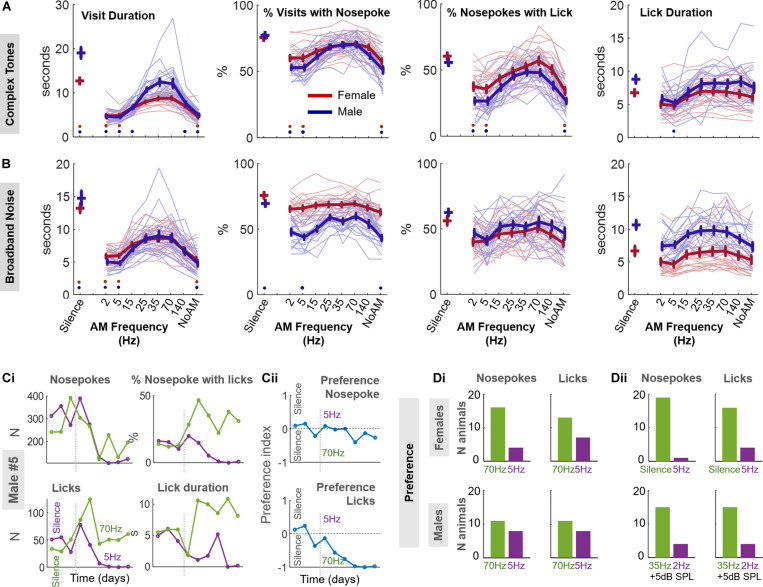
Effects of AM sounds on mouse behavior. (A) The carrier of the AM sound is a complex tone. From extreme left to right: visit duration, percentage of visits with a nosepoke, percentage of nosepokes with a lick, and lick duration, are represented as a function of the stimulus presented (complex tone or silence). The behavior of female (red) and male (blue) animals is displayed. Thin lines are individual data while thick lines display average +/− standard error bars. Red (resp. blue) points at a given AM rate indicate a p < 0.05 for the post-hoc test (see “Materials and Methods” for ANOVA definition) between this AM rate and the 35 Hz for female (resp. male) data. (B) Same as A when the carrier is broadband noise. (C,D) Two-choice protocol. After a 3-day habituation period, each door of the experimental corner is associated with an AM complex tone (5 Hz on left door, 70 Hz on right door) for 6 days. (C) Example results for male #5. (Ci) Number of nosepokes (upper left), licks (lower left), percentage of licking for each nosepoke (upper right) and lick duration (lower right) in each door across days. Green (resp. purple) line represents the right (resp. left) door. (Cii) Preference index for nosepokes (up) and licks (down) across days, see “Materials and Methods.” (Di) Numbers of animals which nosepoke (up) and lick (down) preferentially at the door associated with 70 or 5 Hz for females (top) or males (bottom). (Dii) Same than (Di) for females tested on the silence vs 5 Hz protocol (top) or males tested on the protocol 35 vs. 2 Hz with an additional 5 dB SPL for both sounds (bottom).